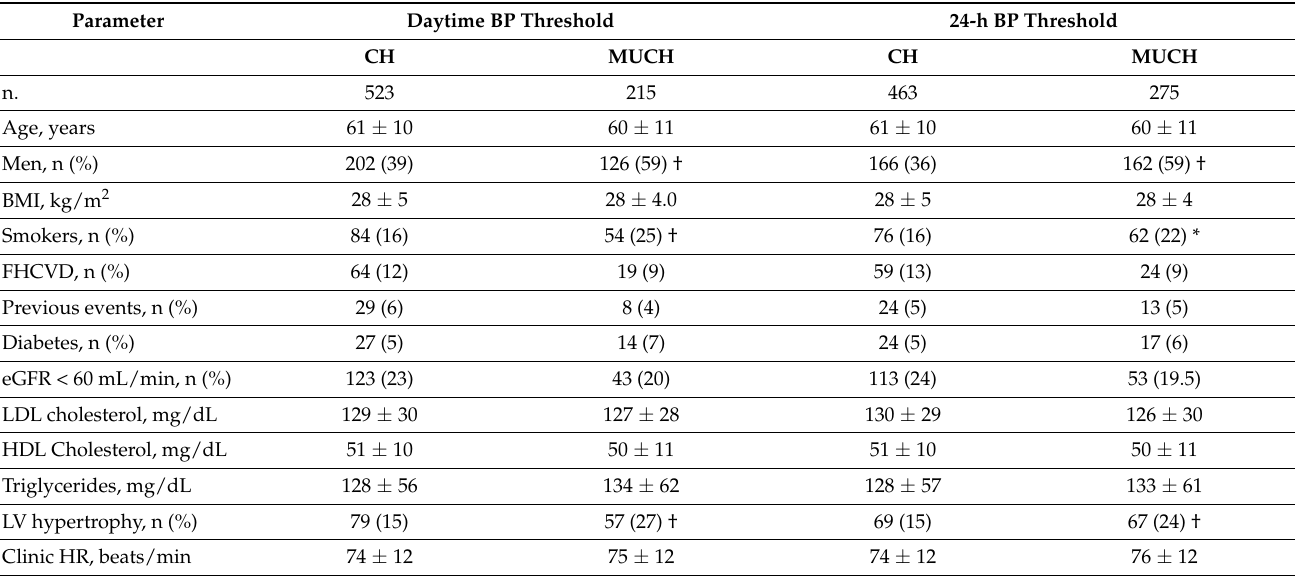
Table 1. Characteristics of study